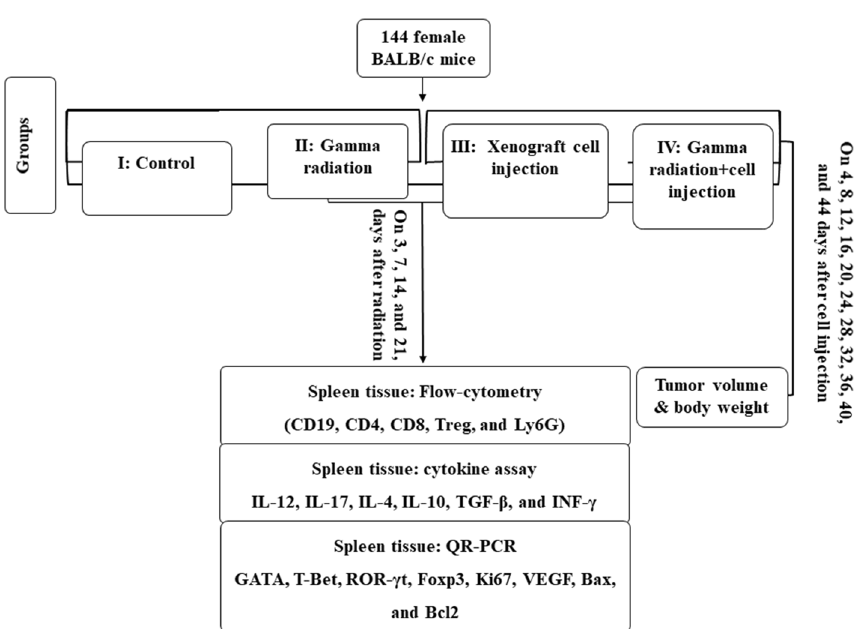
Figure 6. Schematic design to develop gamma-irradiated immunosuppressed